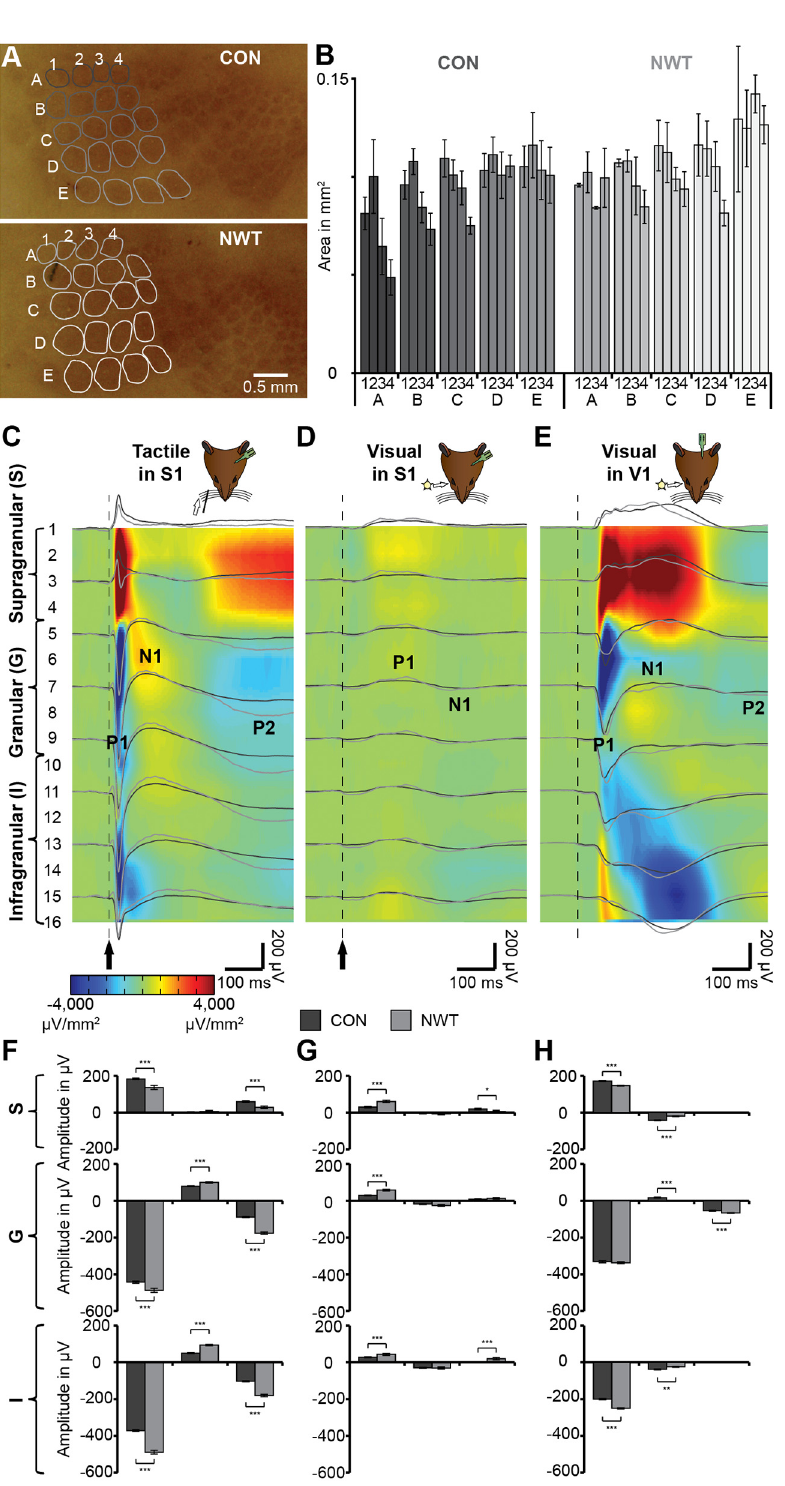
Fig 2. Effects of neonatal whisker trimming on the topographic organization of the adult barrel field and on unimodal evoked responses in S1 and V1. ( A ) Flattened histological sections including the posteromedial barrel field of the S1 stained for COX from a CON (top) and a NWT (bottom) rat. Barrel rows and columns are marked with letters and numbers. ( B ) Bar diagram displaying the size of individual barrels averaged for seven CON and seven NWT rats. ( C ) Averaged tactile potentials evoked by contralateral whisker deflection in S1 of CON (black traces) and NWT (gray traces) rats displayed together with